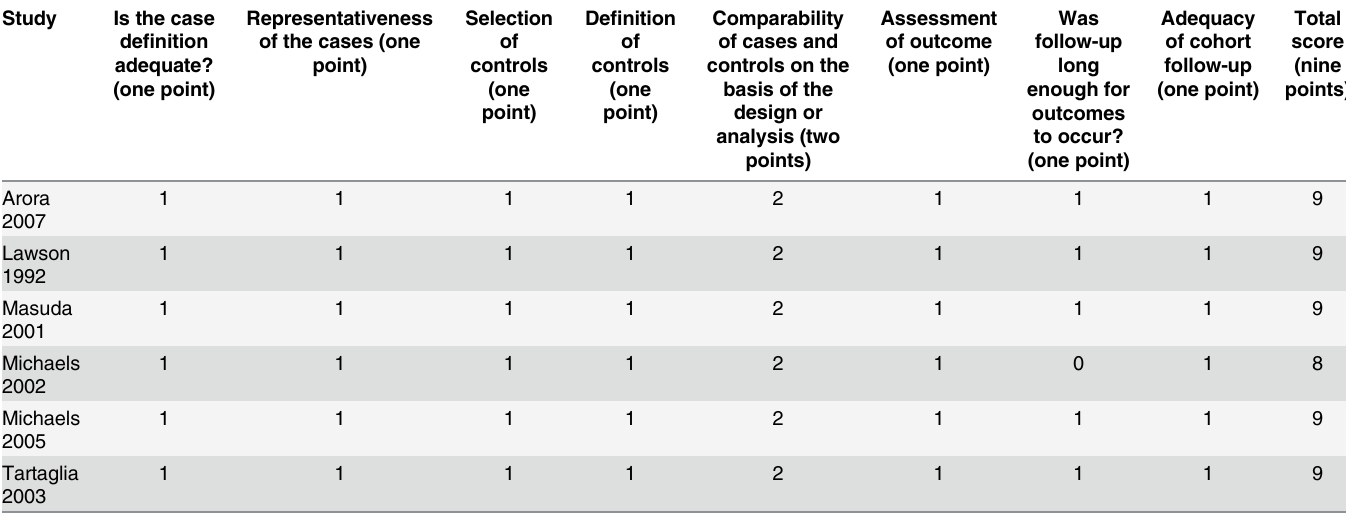
Table 2. Newcastle-Ottawa Scale Quality Assessment of Included Studies.